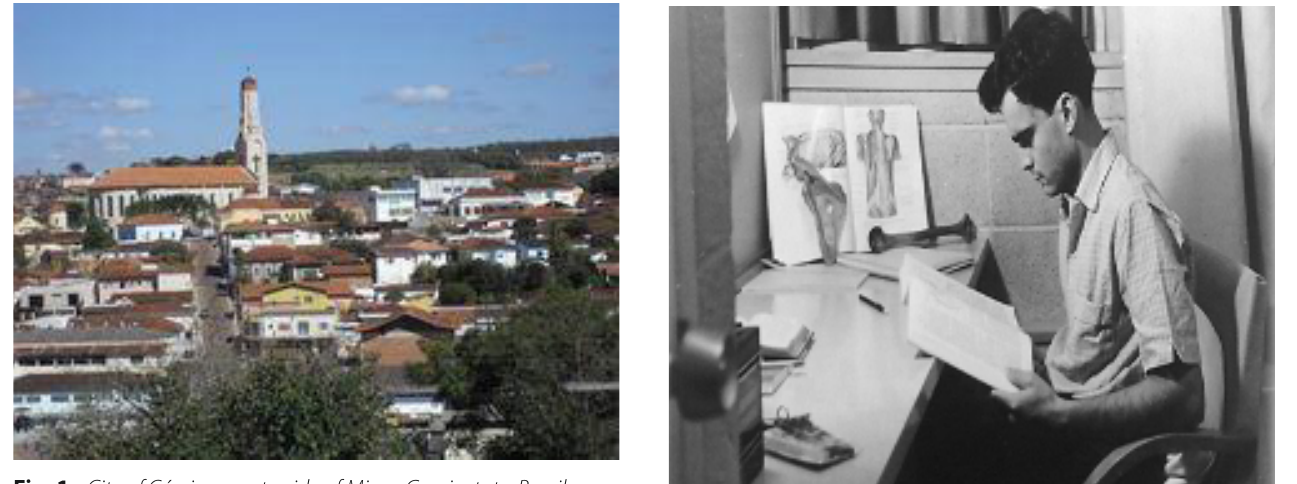
Fig. 1 - City of Cássia, countryside of Minas Gerais state, Brazil.